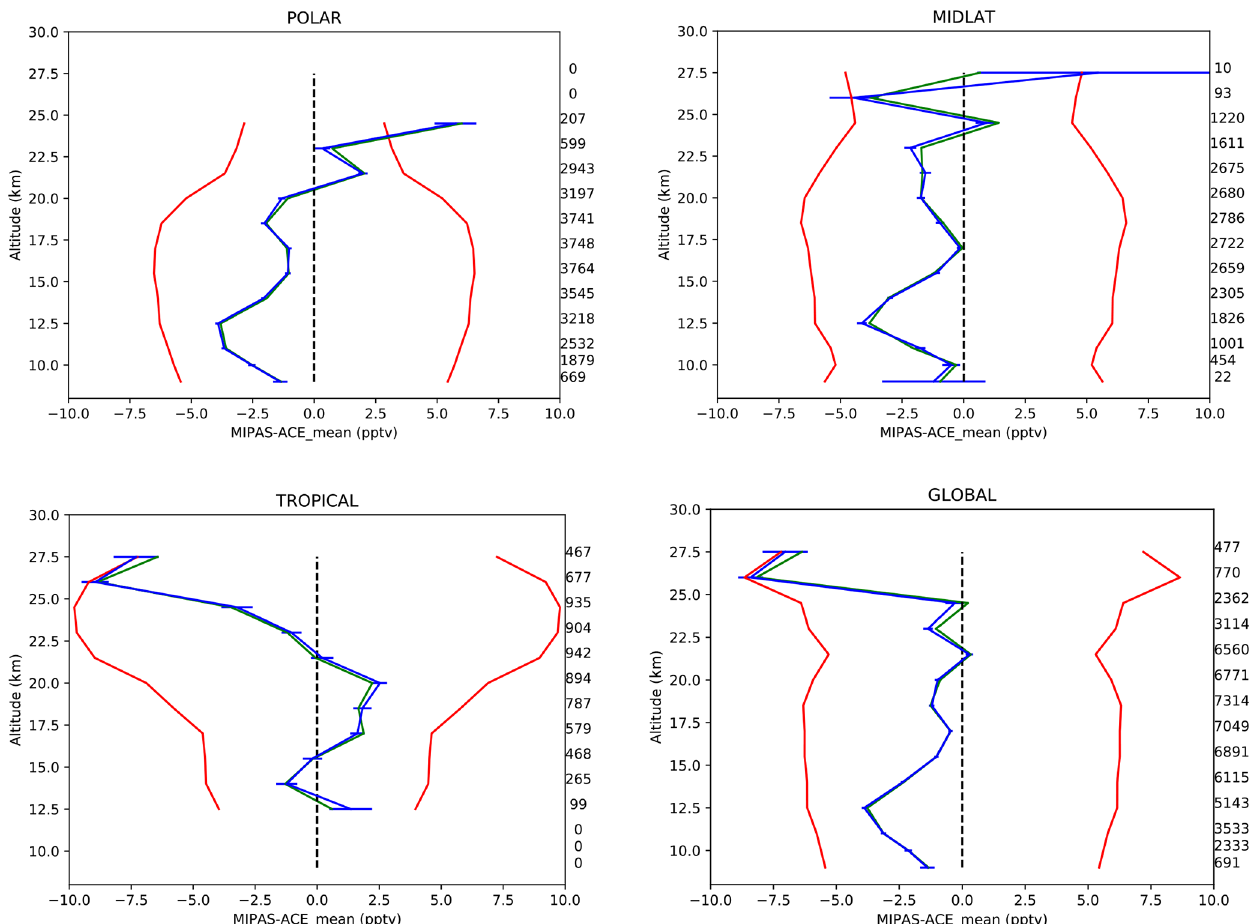
Figure 6. Average differences (blue) between MIPAS and ACE-FTS COCl 2 profiles for several latitude bands (see plot’s key). The median differences are shown in green. Blue bars and red lines represent the random and systematic combined error components, respectively. The number of matching measurements is indicated on the right-hand